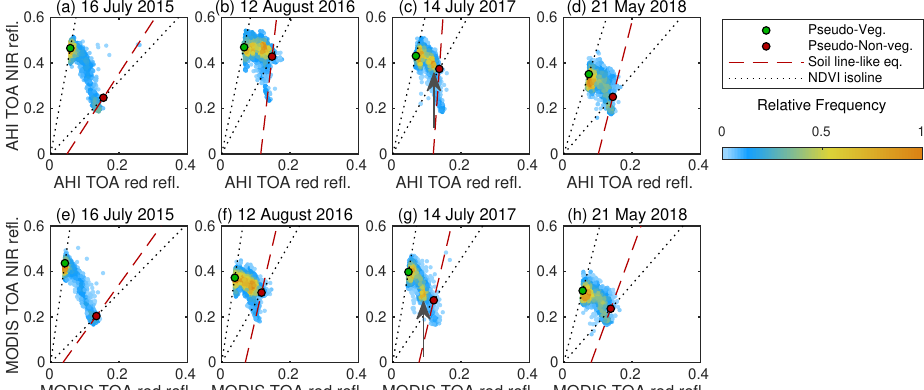
Figure 8. Density scatter plots of the red and NIR reflectances over the Hokkaido region on 16 July 2015, 12 August 2016, 14 July 2017, and 21 May 2018, excluding water bodies. ( a – d ) correspond to AHI and ( e – h ) correspond to MODIS. Green and brown circles indicate pseudo-vegetation and non-vegetation endmember spectra. The brown dashed line was based on the soil line-like equation, and dotted lines indicate the NDVI isoline for the endmember